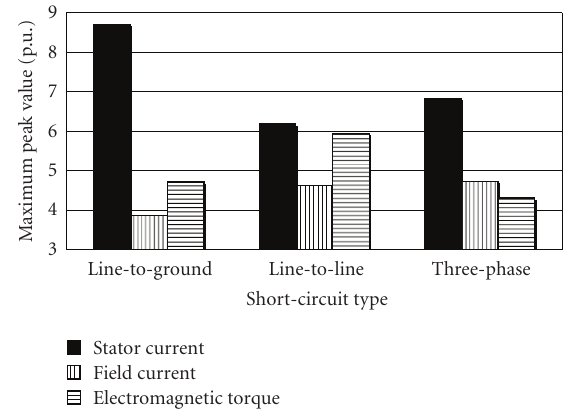
Figure 6: Comparative overview on the maximum peak values of short circuit characteristic